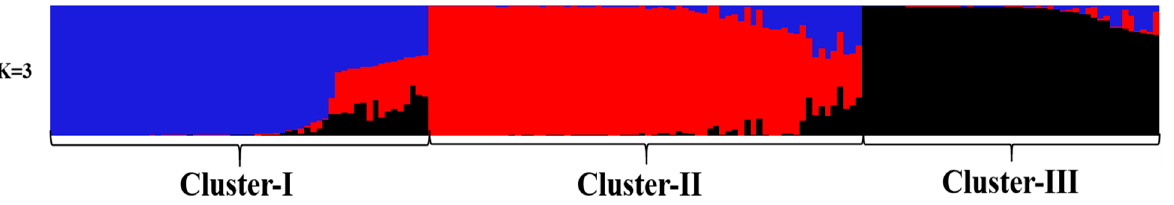
Figure 7. Genetic structure of the 179 persimmon germplasms revealed by STRUCTURE analysis.